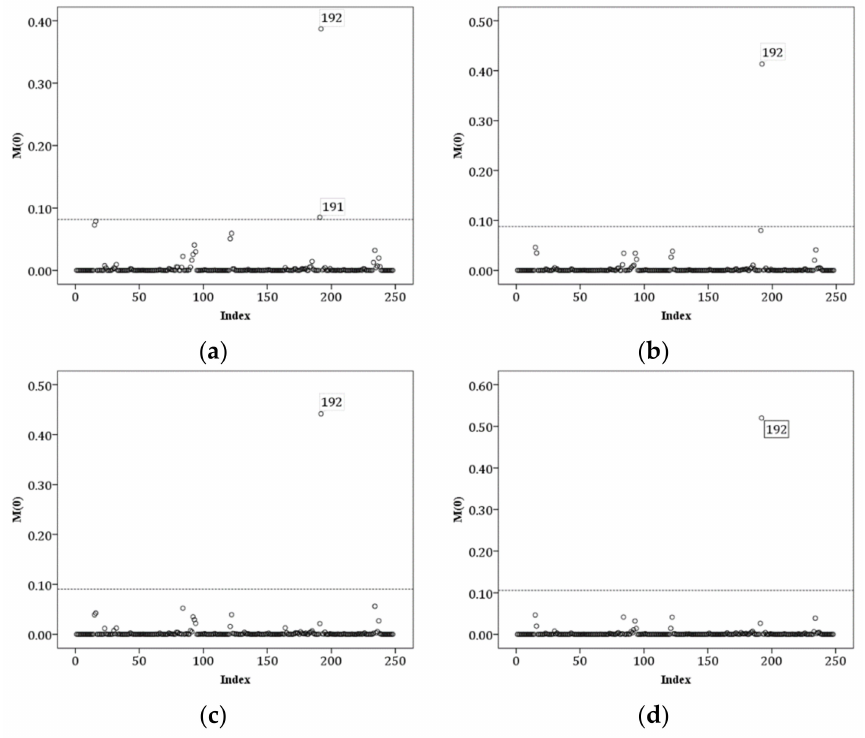
Figure 4. Index plots of M (0) for the perturbation of the dispersion matrix of the errors for the four scenarios. Dotted lines show the yardstick for M (0) with c ∗ =